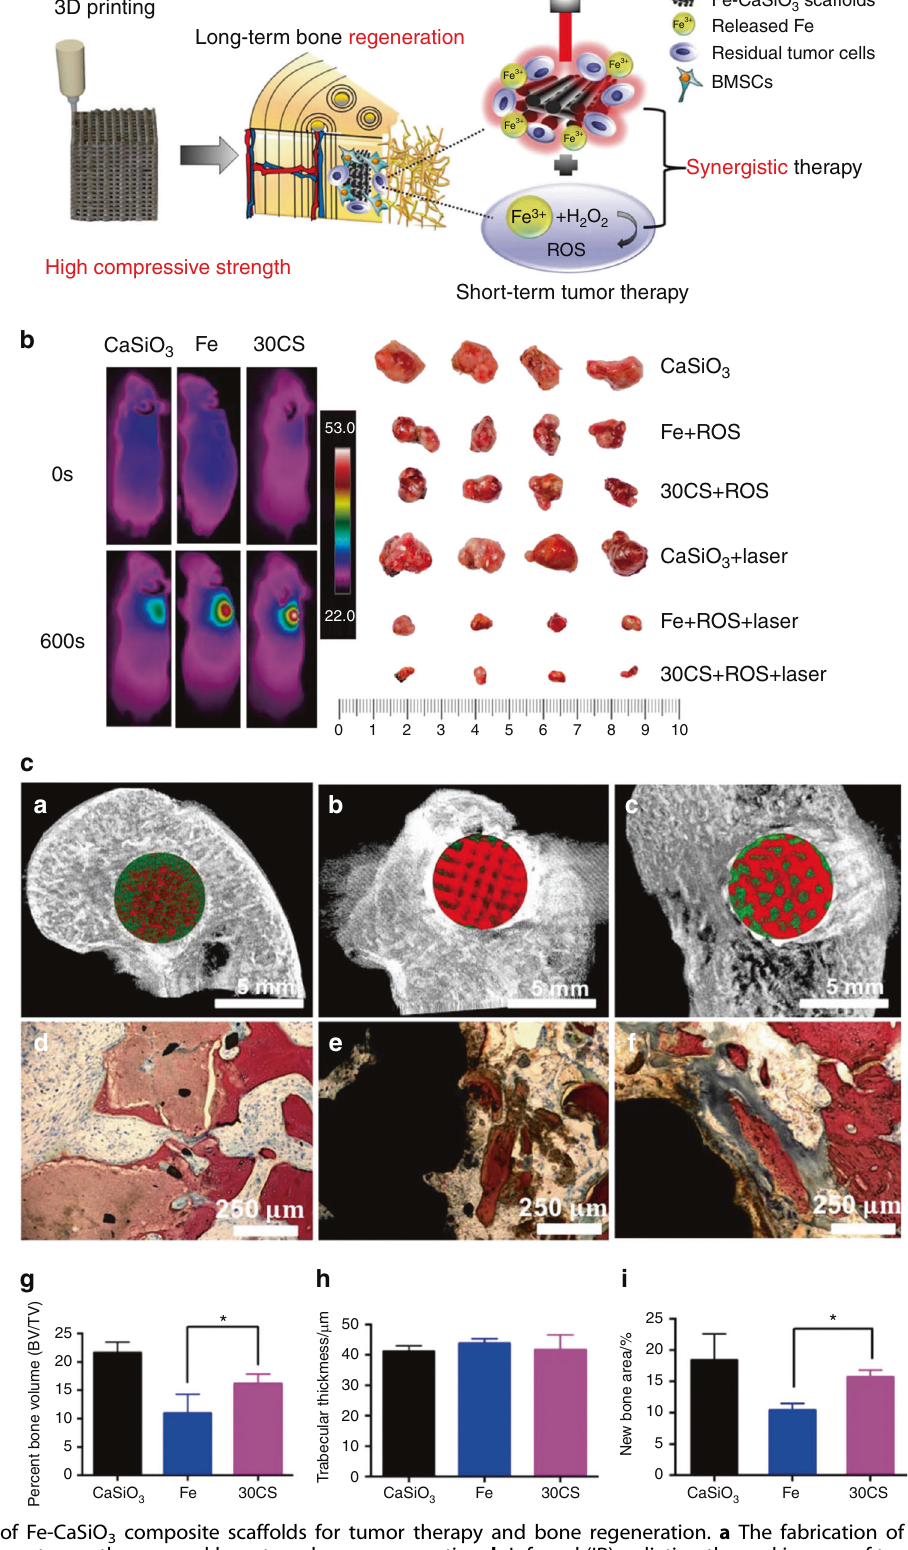
Fig. 2 3D printing of Fe-CaSiO 3 composite scaffolds for tumor therapy and bone regeneration. a The fabrication of Fe-CaSiO 3 composite scaffolds for short-term tumor therapy and long-term bone regeneration. b Infrared (IR) radiation thermal images of tumor-bearing mice after irradiation with an 808 nm laser for 600 s. The photographs of the tumors from the six groups are from day 15. c Micro-CT images ( a – c ) and histological analysis ( d – f ) of the bone defects in the CaSiO 3 , Fe, and Fe-CaSiO 3 (30CS) groups postsurgery in a rabbit critical-sized femoral defect model. The statistical analysis of the defects ( g , h ) and histomorphometric measurements of in vivo osteogenesis ( i ) in the CaSiO 3 , Fe, and 30CS groups 8 weeks post surgery. Reprinted with permission from ref. 99 © 2018, Nature Publishing